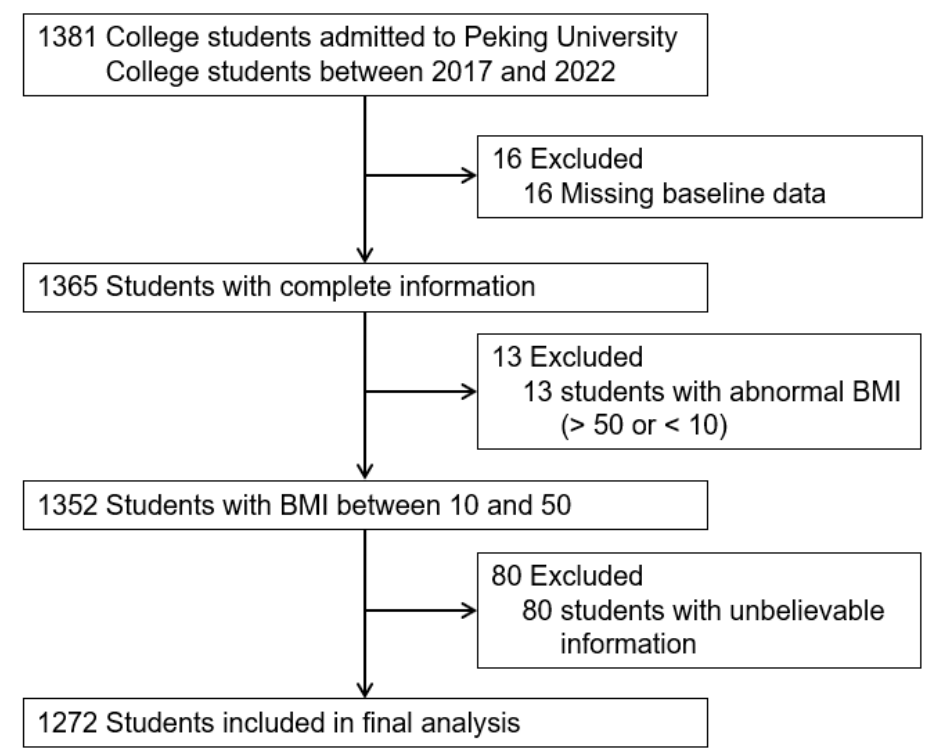
Figure 1. Flow diagram of inclusion and exclusion of study participants. BMI, body mass index.